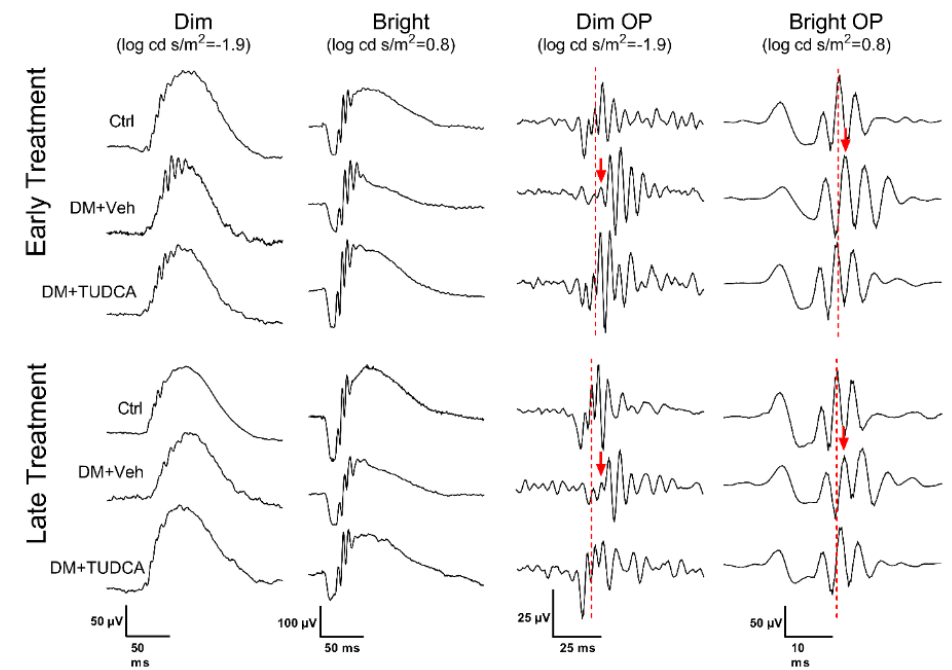
Figure 3. Representative waveforms from dim (log cd s/m 2 = − 1.9) and bright (log cd s/m 2 = 0.8) stimuli, as well as filtered OPs, at week 8 post-STZ for both early and late treatment. Dashed lines indicate the peak of OP2 in the Ctrl waveform, whereas the red arrows indicate the delayed peak of OP2 in the DM+Veh animals.